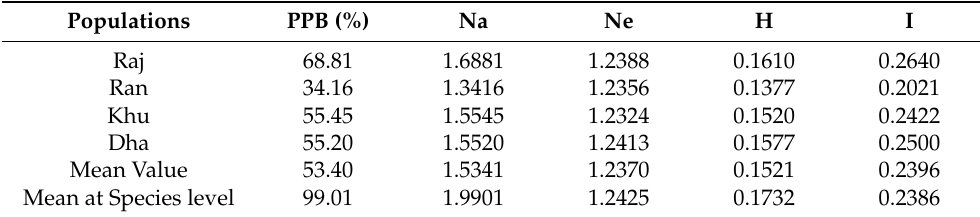
Table 6. Genetic structure of C. falcatum isolates collected from four geographic regions of Bangladesh analyzed using10 ISSR markers.